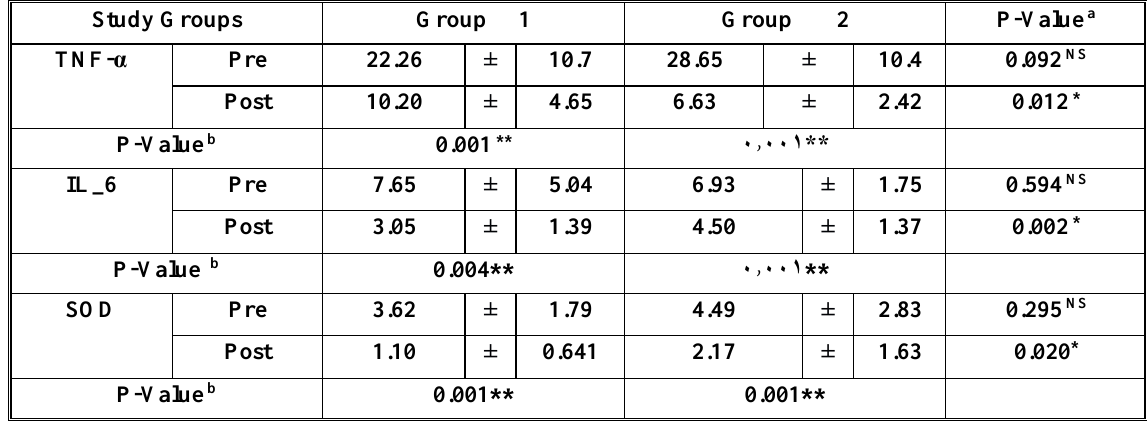
Figure 5. Effect of treatment on IL-6 levels in patients with diabetic neuropathy. Table 4. Effect of treatment on TNF-α, IL-6 & SOD in patients with diabetic